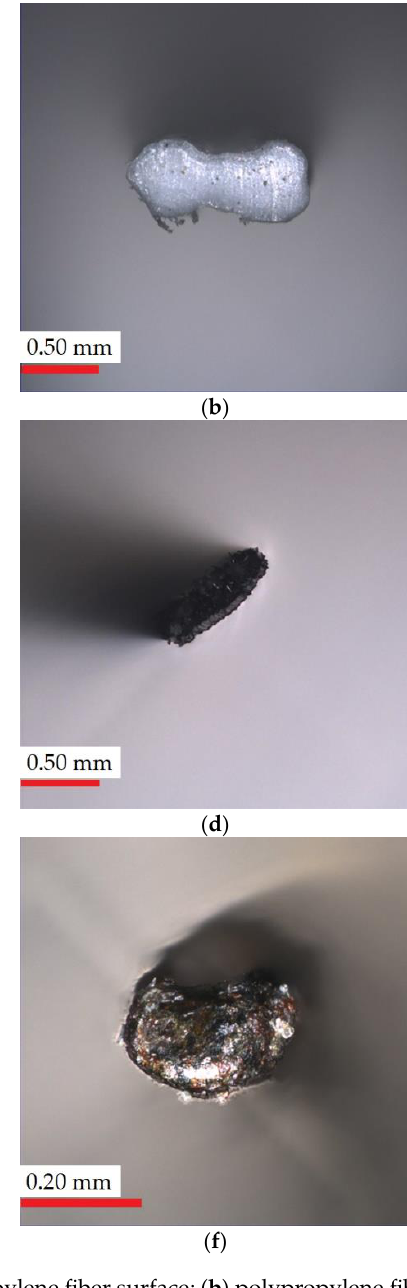
Table 6. Experimental results of material and thermal properties (average values).